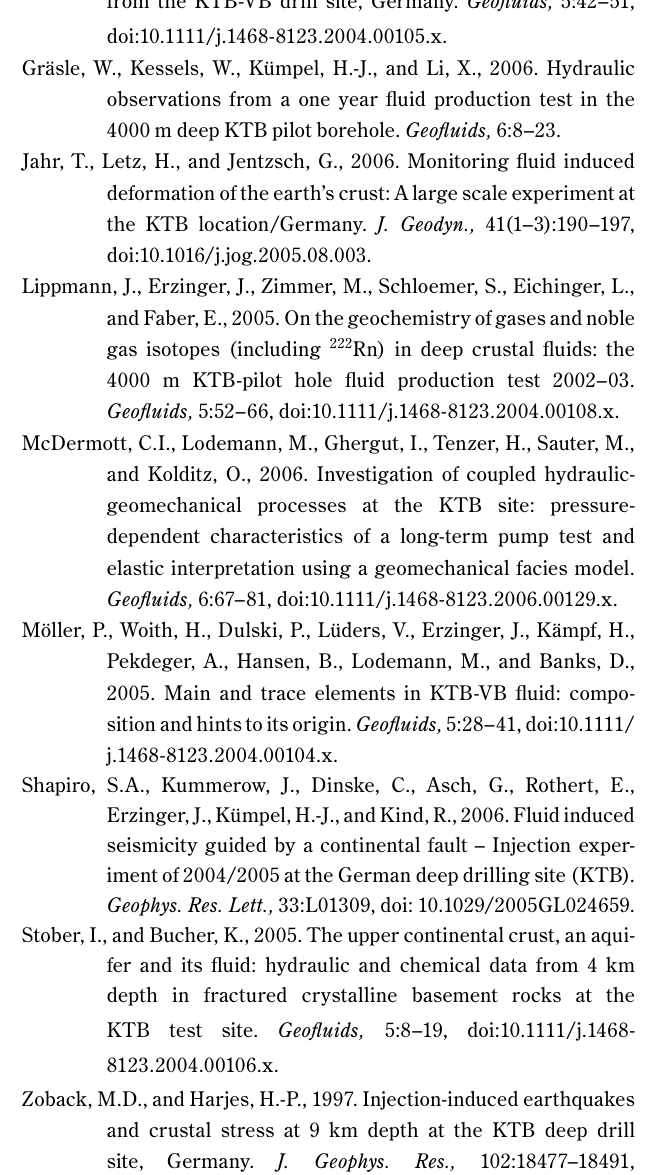
Fig. 3: photograph by Günter Asch and Jörn